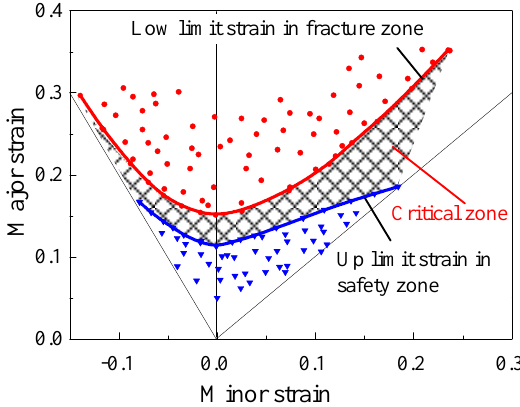
Figure 10. Forming limit diagram for test measurement.